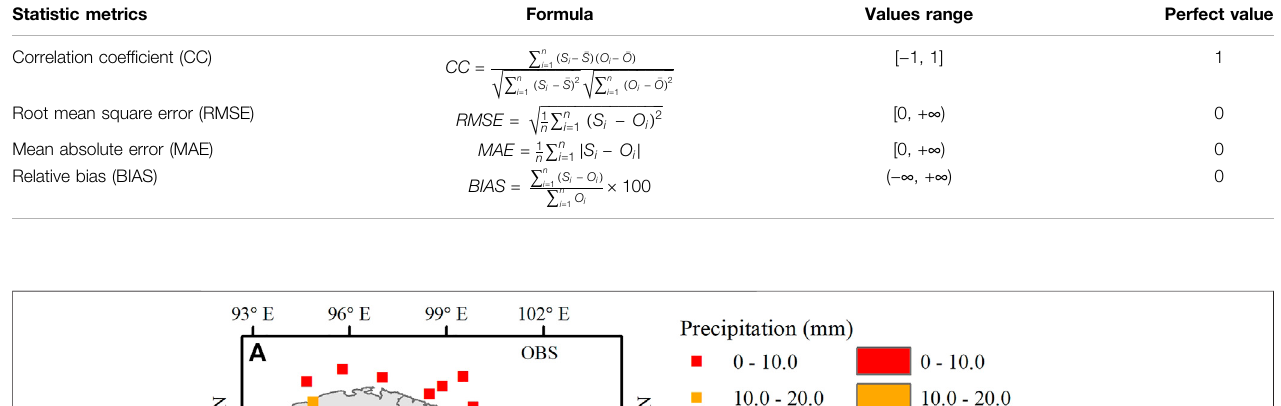
TABLE 2 | Information on the statistical indices used in this study.